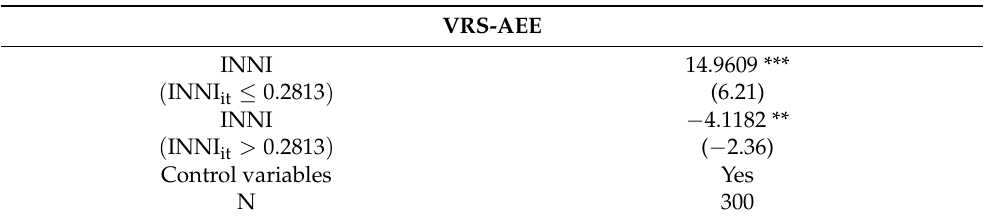
Table 8. Innovative infrastructure and VRS AEE threshold value.